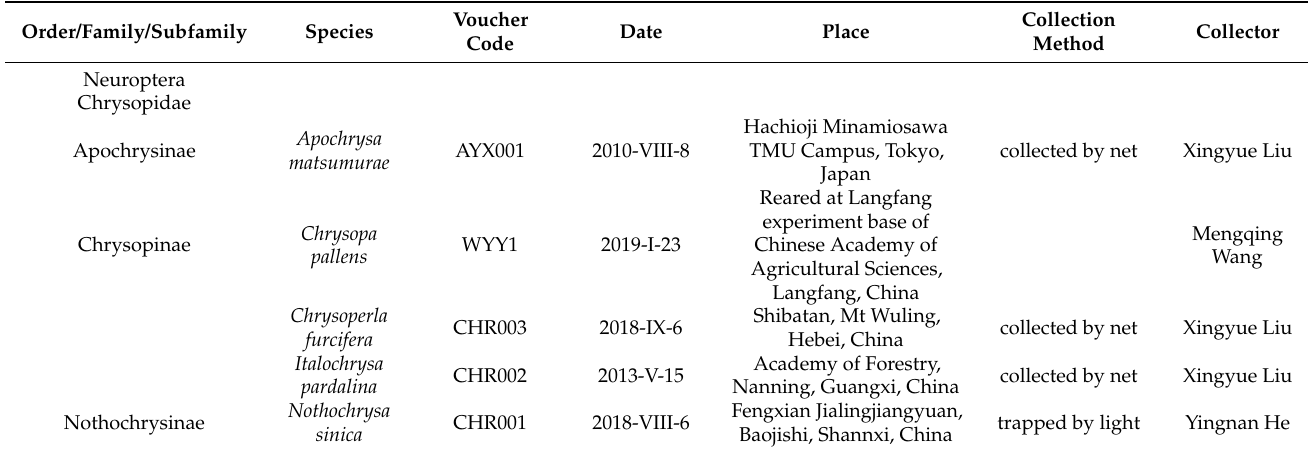
Table 1. Collection information on species used in this